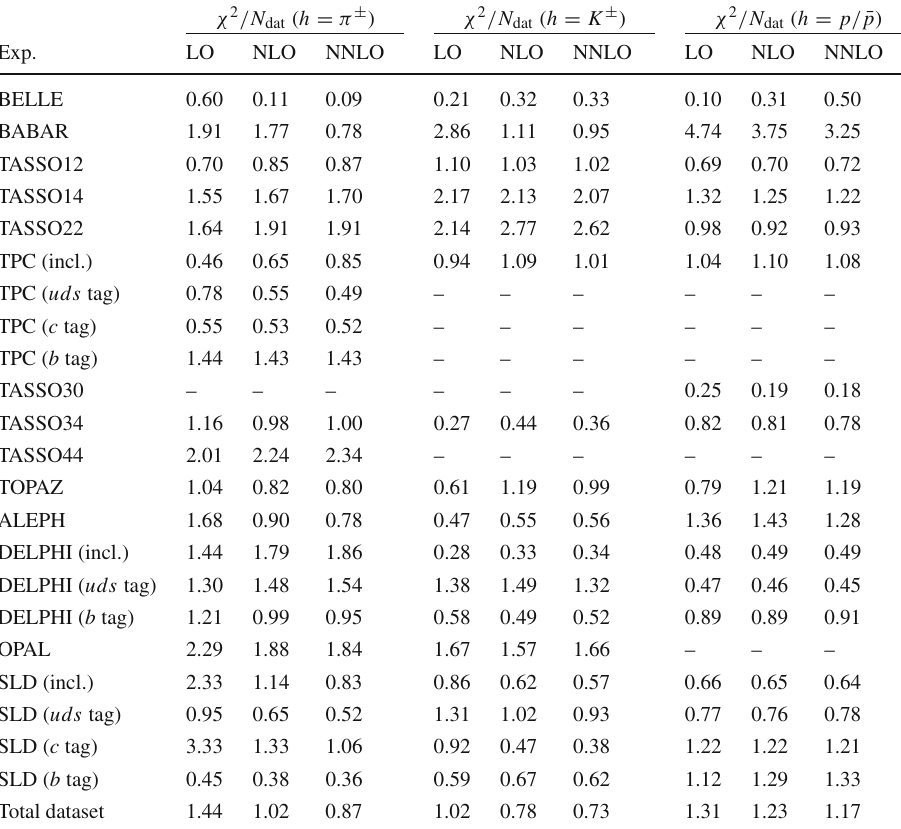
Table 3 The values of χ 2 / N dat for each hadronic species, perturbative order and experiment included in the NNFF1.0 analysis. The number of data points N dat in each case is reported in Table